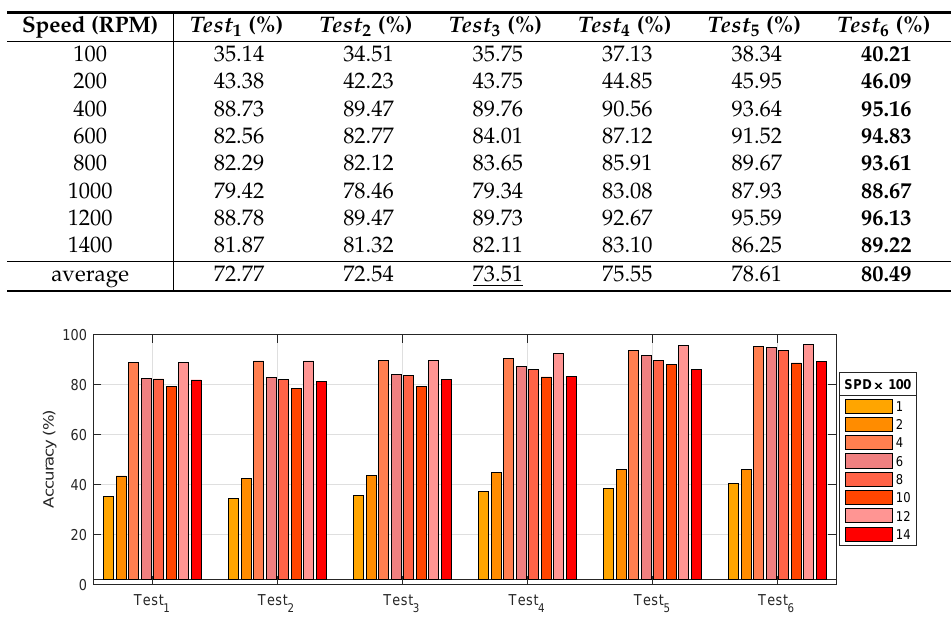
Figure 14. Recognition accuracy comparison of different test